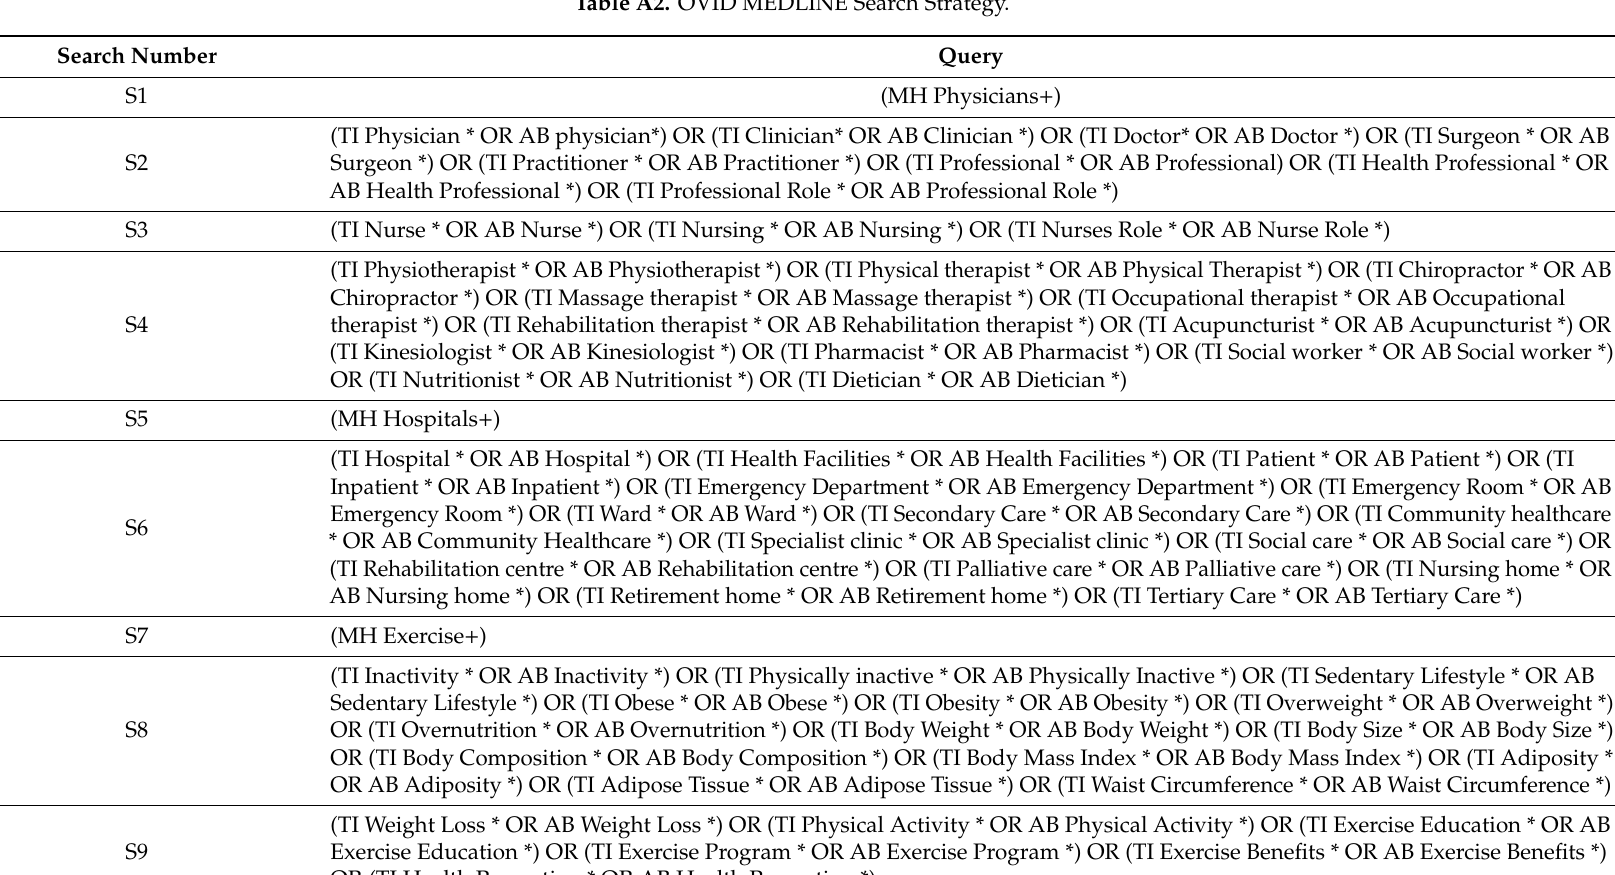
Table A2. OVID MEDLINE Search